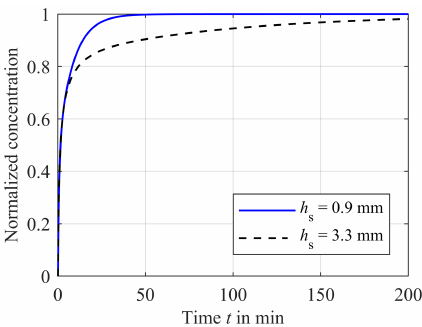
Figure 3. Comparison of the concentration in the sensor compart- ment close to the ISE between h s = 0.9mm (blue solid line) and h s = 3.3mm (black dashed line) versus the time t after a step in concentration of the extracorporeal circuit from zero to c 0 , nor- malized to the highest concentration c 0 . The diffusion coefficient is D Ca = 0.9 × 10 − 9 m 2 s − 1 .